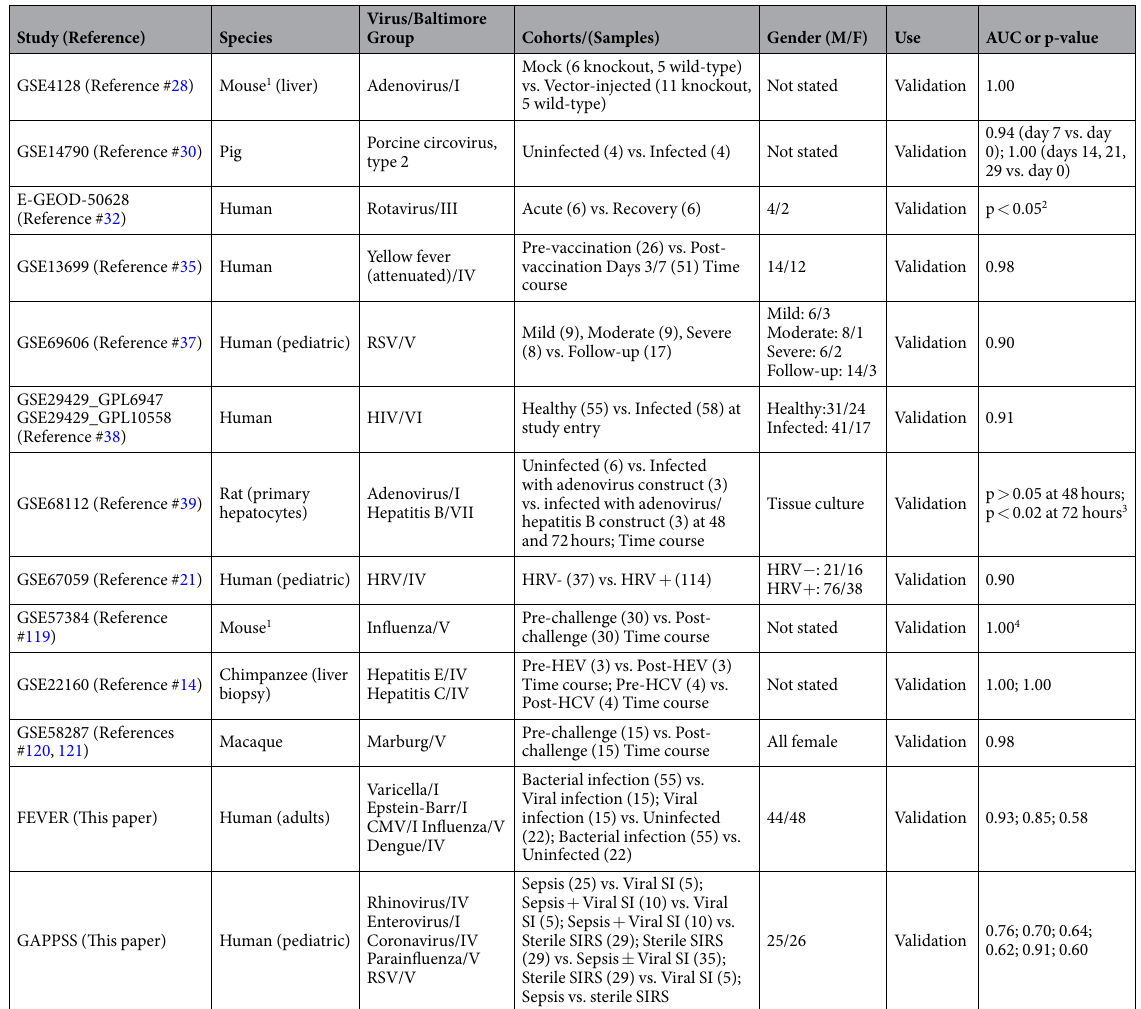
Table 3. Validation datasets used in this study. Details of datasets used for validation of the pan-viral signature are listed including: an associated reference (if available), species studied, virus types represented, cohorts compared and the number of samples in each, gender numbers, how the dataset was used, and the performance (AUC) of the pan-viral signature in the cohorts described. Sample type analyzed was blood unless otherwise noted in the Species column. 1 The mouse ortholog OASL1 of the human gene OASL was used in the analysis of mouse GEO datasets. 2 Mann-Whitney U test. 3 One-tailed t-test, assuming unequal variances between the two comparison groups. 4 Pan-viral signature AUC evaluated over days 2–6 post-infection, compared to pre- infection state